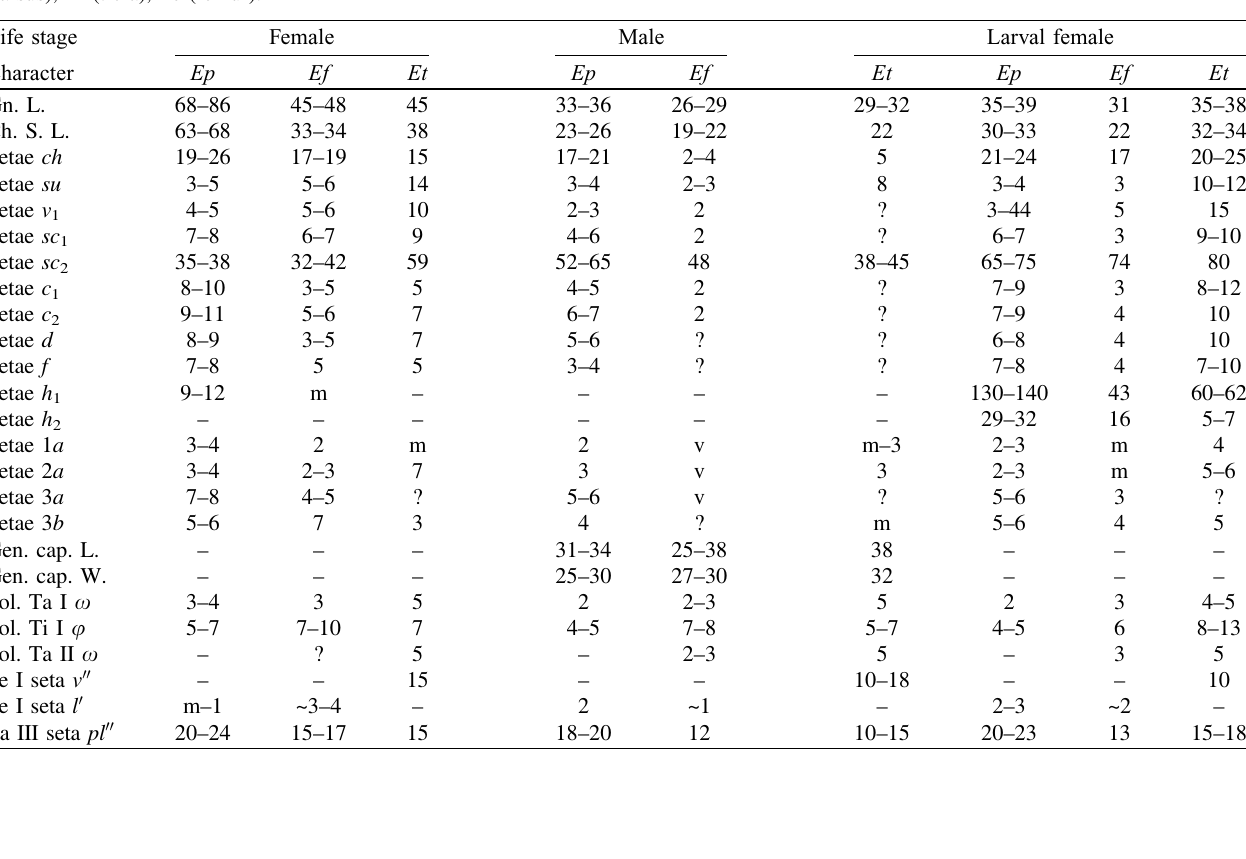
Table 1. Comparison of selected characters (range of measurements if available) of E. paryavae n. sp. ( Ep ) with two closely related species of the pterostichi species group: E. fi scheri ( Ef ) and E. teteri ( Et ). Dashes ( – ) denote absence of the character. Characters for which the data are obscured/not available in the original descriptions are given as question marks (?). Letters v and m indicate vestigial and mirosetae, respectively. Abbreviations: L. (length), S. (stylet), Gn. (gnathosoma), Gen. cap. (genital capsule), Ch. (chelicera), Sol. (solenidion), Ta (tarsus), Ti (tibia), Fe